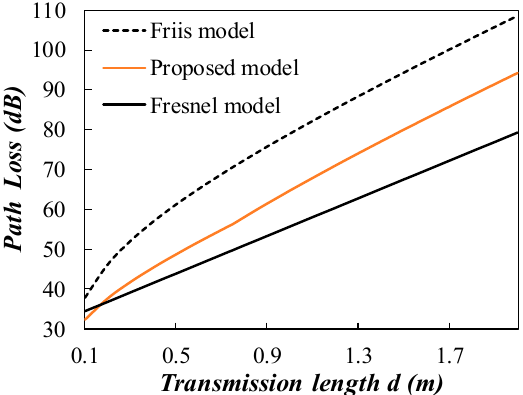
Figure 4. Comparison between the Friis model and the Fresnel model; f = 433 MHz, soil equivalent complex permittivity 13.25–2.18 j .